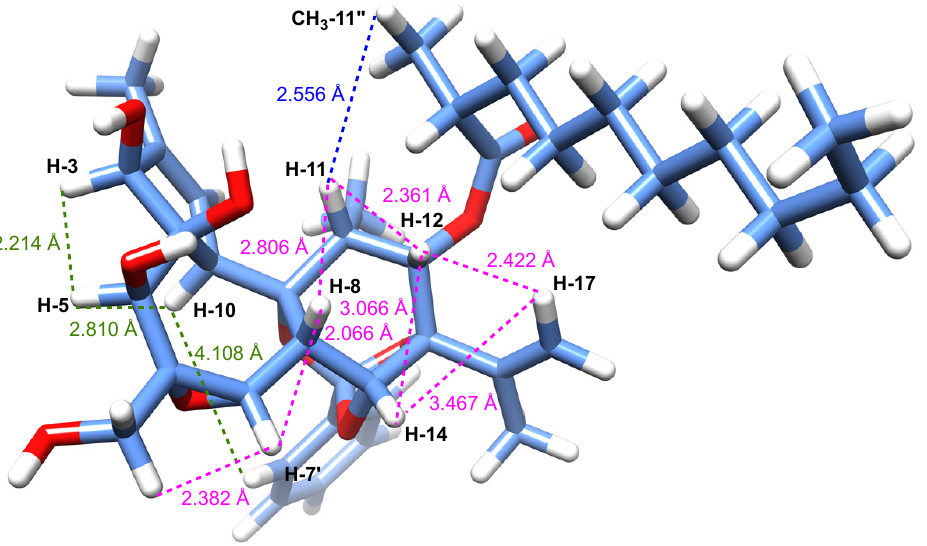
Figure 3. 3D representation of a possible conformer of 1 as derived from energy minimization showing distances (Å) between ROE-interacting protons (distances are shown in dotted lines in green and magenta for protons below and above the plan, respectively). The R * configuration was assigned arbitrarily for